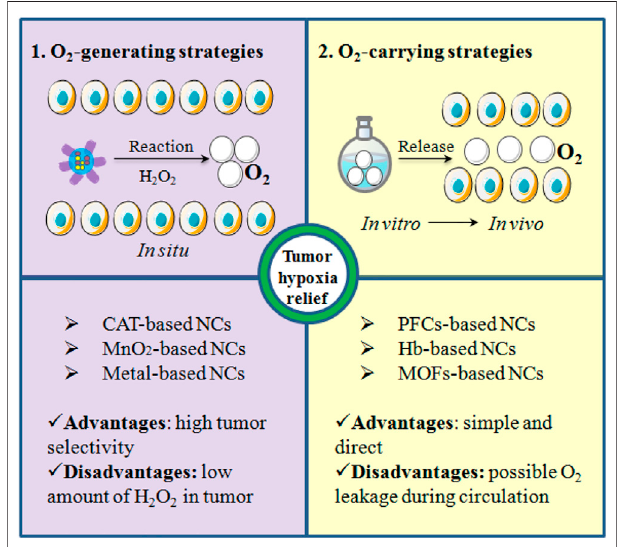
FIGURE 2 | Schematic diagram of oxygen-generating strategies and oxygen-carrying strategies for tumor hypoxia relief: varieties, advantages, and disadvantages.